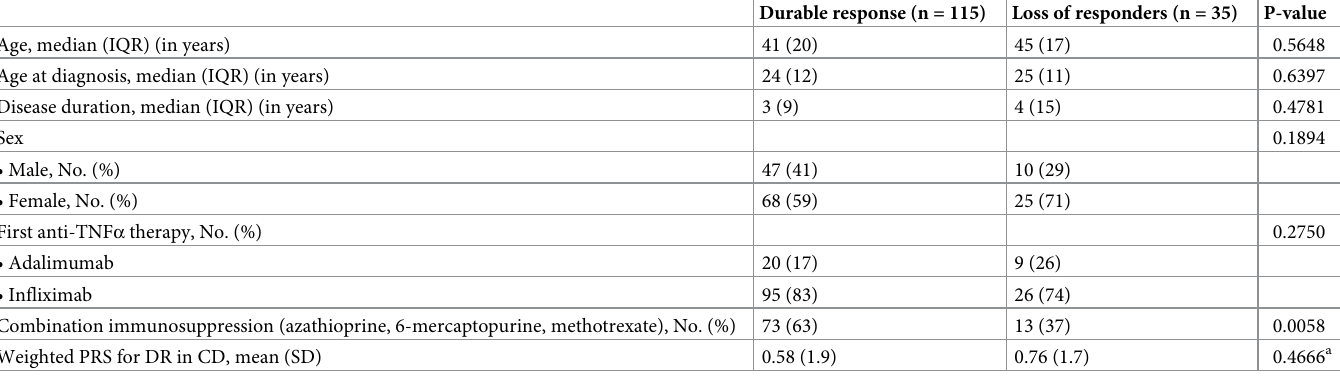
Ulcerative colitis Predictors of primary non-response. We identified 112 patients with UC who had received anti-TNF α therapy. Of these patients, we identified 12 (11%) patients with PNR and Table 2. Comparison of characteristics of patients with Crohn’s disease exposed to anti-tumour necrosis factor alpha therapy with durable response and loss of response. Durable response (n = 115) Loss of responders (n = 35) P-value